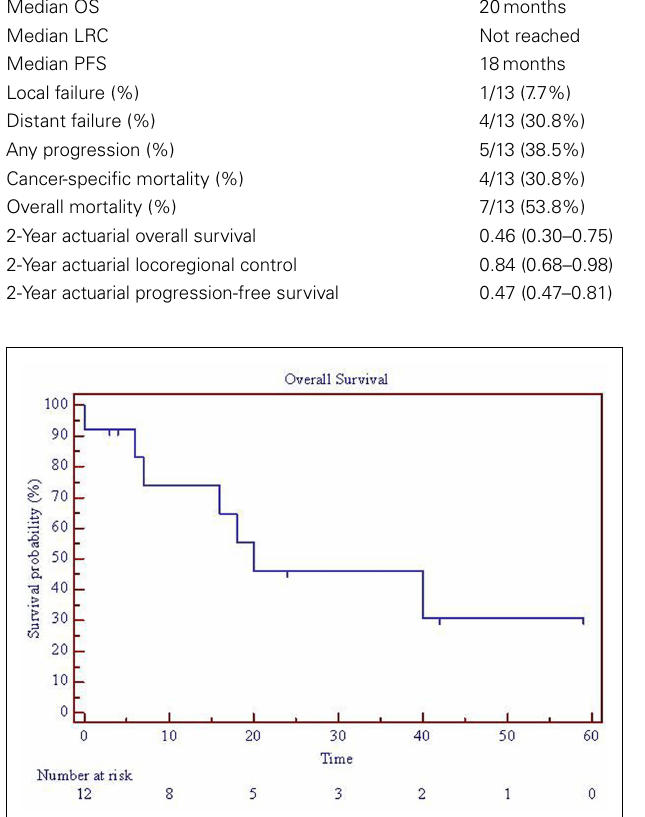
FIGURE 1 | Overall survival for patients with parotid tumors treated with SBRT. One patient died on treatment at time 0, so 12 patients are represented. SBRT = stereotactic body radiation treatment.